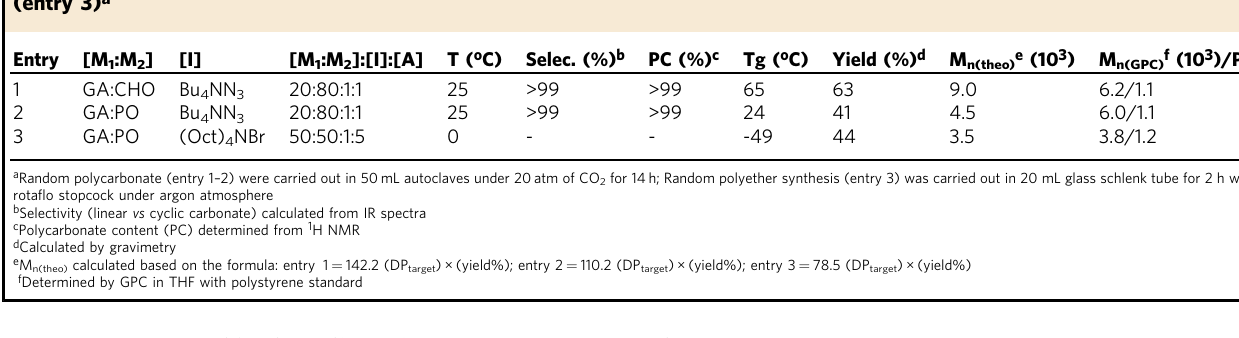
Table 3 Random terpolymerization of GA with epoxide monomers and CO 2 (entries 1 and 2) and copolymerization of GA with PO (entry 3) a